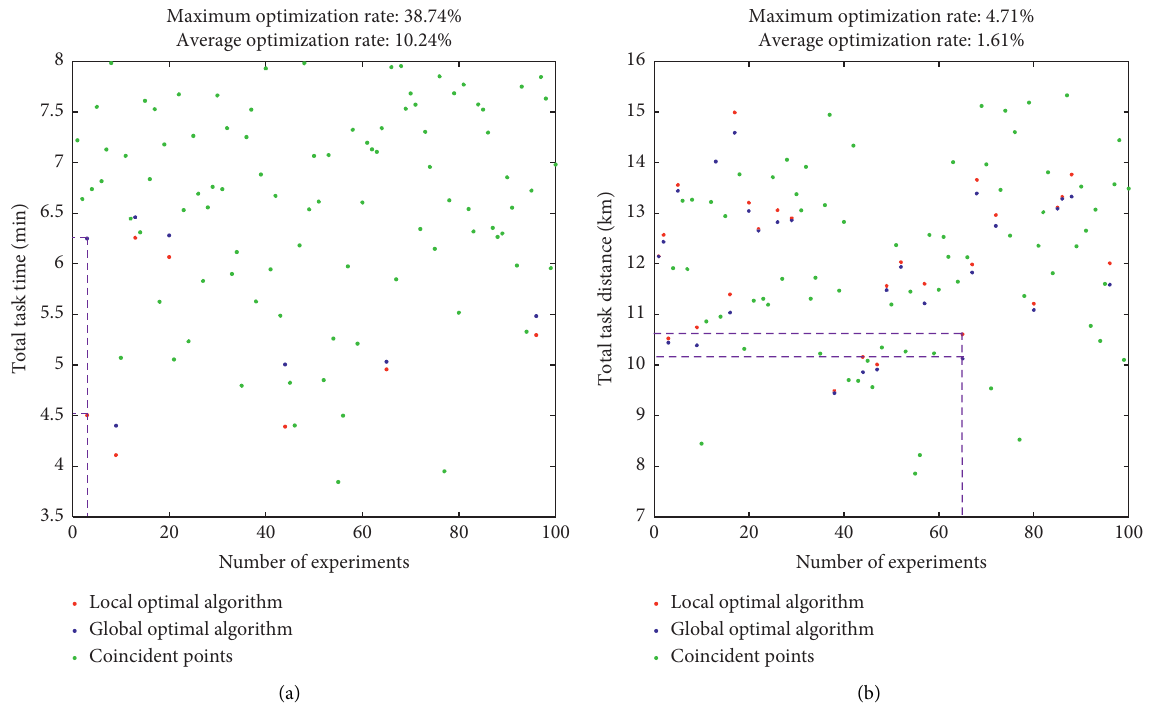
Figure 7: The results of two algorithms when R � 1 km: (a) total task time of two algorithms; (b) total task distance of two algorithms. Maximum optimization rate: 38.74%; maximum optimization rate: